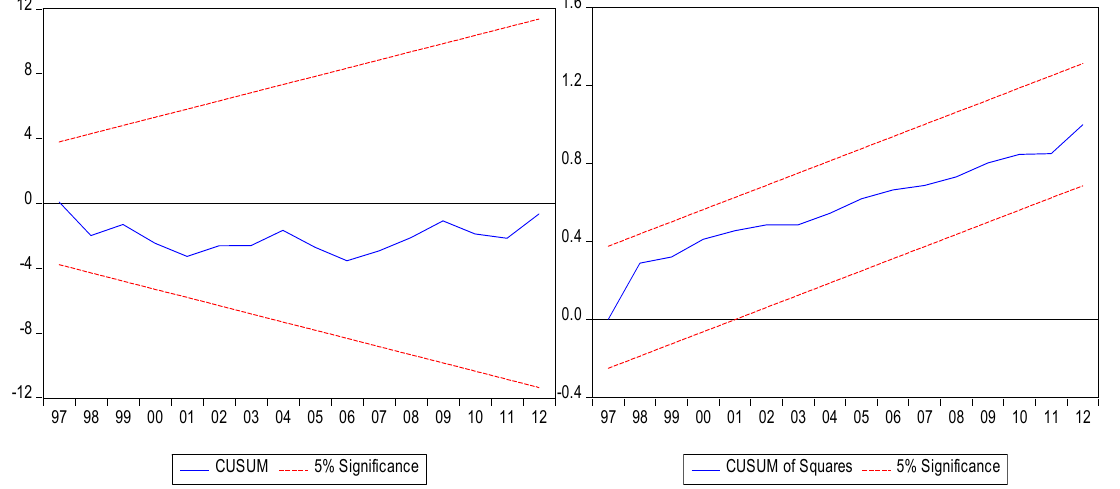
Figure 5. CUSUM and CUSUM of squares test for the linear model.